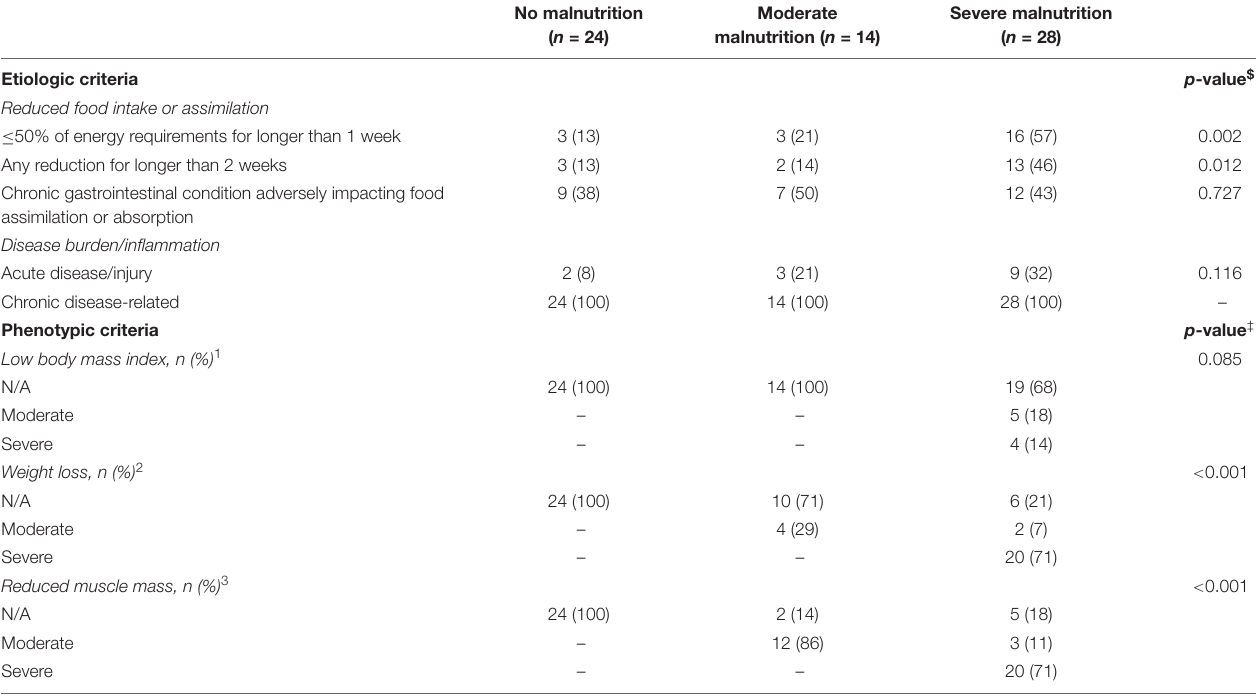
TABLE 2 | Prevalence of etiologic and phenotypic GLIM criteria among patients with chronic pancreatitis.